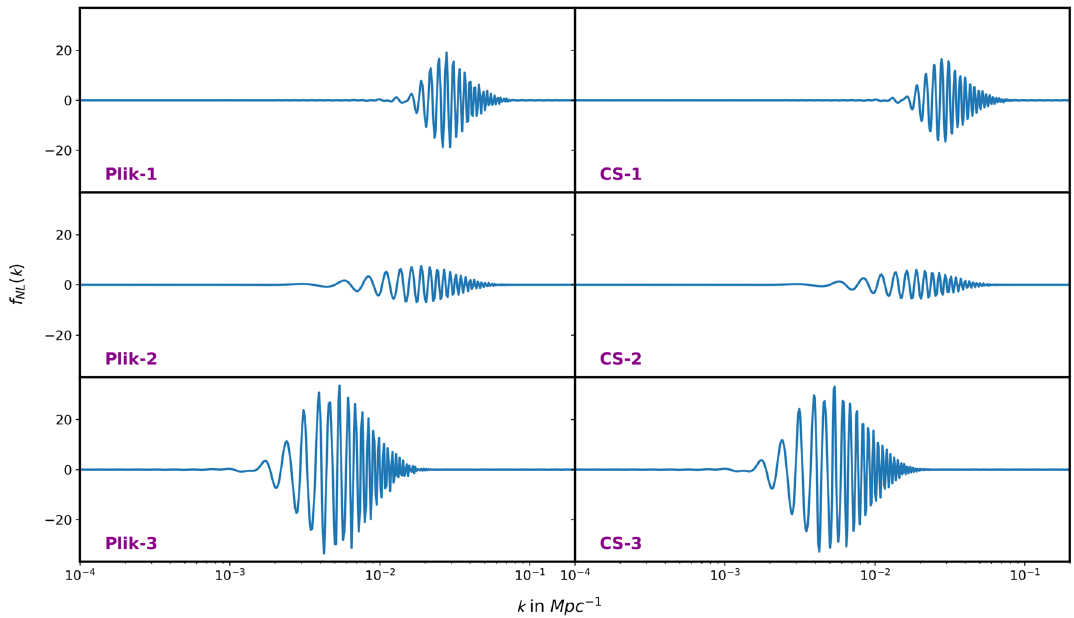
Fig. 9 Scalar bi-spectrum evaluated in the equilateral limit for the best-fit candidates of the both Plik-bin1 (left side) CamSpec clean (right side) likelihood